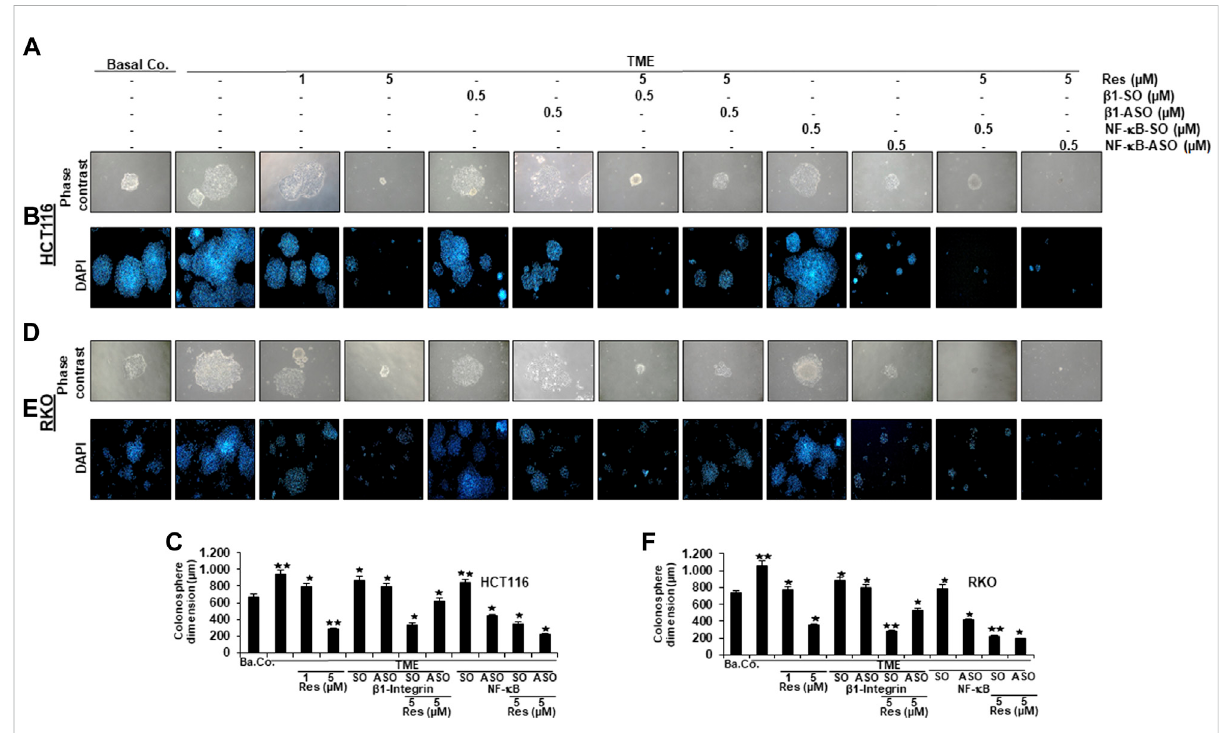
FIGURE 5 Impact of resveratrol or/and ASO against β 1-integrin or against NF- κ B on TME-promoted CRC cell metastasis and formation of colonospheres in alginate cultures. Serum-starved HCT116 (A,B) and RKO (D,E) cells from 3D-alginate, settled on square cover glasses as colonies under different treatment conditions: untreated (Basal Co.), TME control, resveratrol (1, 5 µM), β 1-SO/ASO (0.5 µM), NF- κ B-SO/ASO (0.5 µM) or combinationof SO/ ASO (0.5 µM) and resveratrol (5 µM). CRC cells were photographed using phase contrast (magni fi cation ×100, Zeiss Axiovert 40